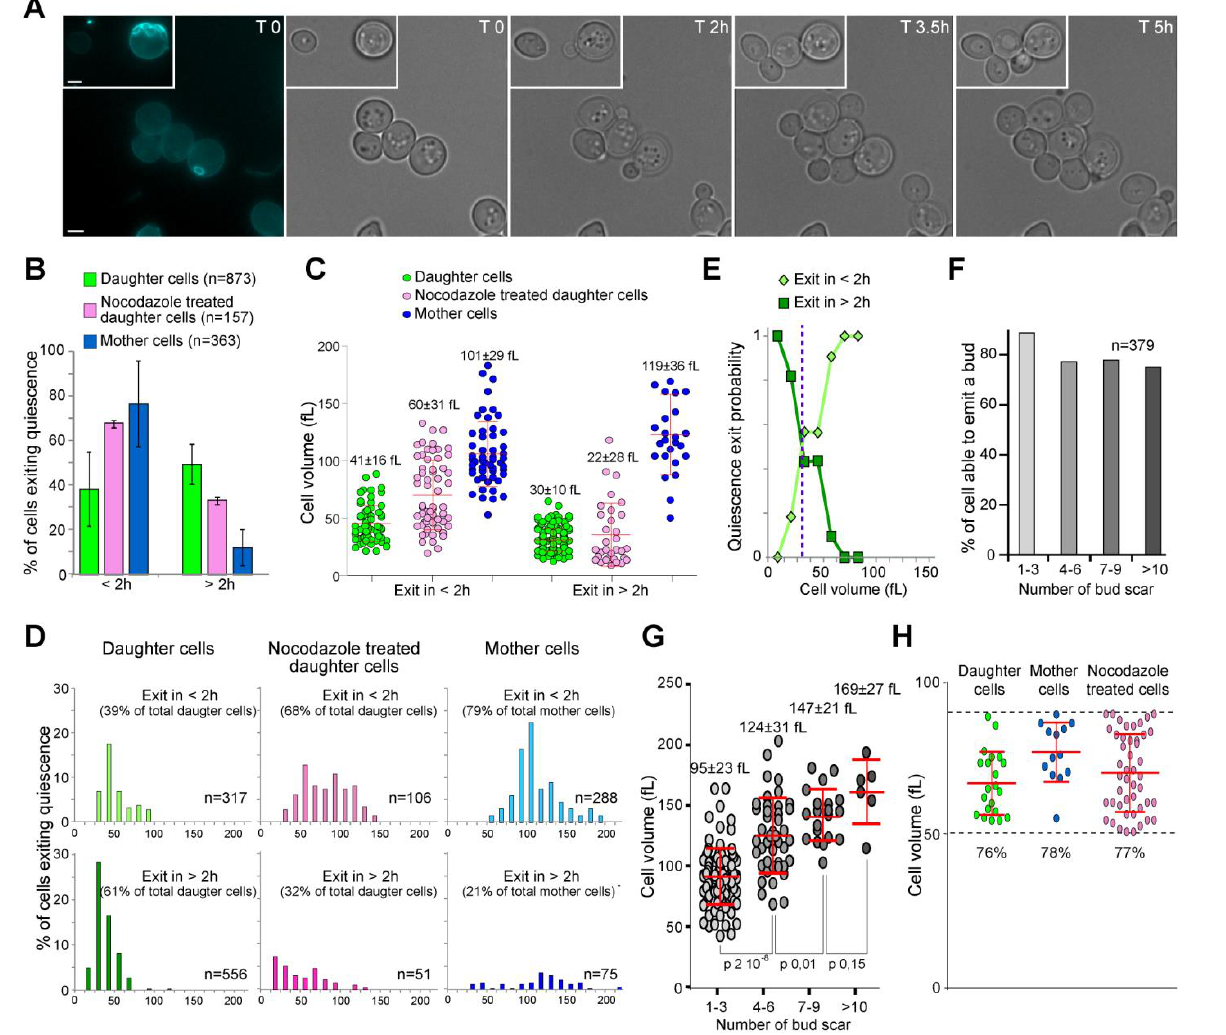
FIGURE 1: Daughter and mother cell quiescence exit efficiency. (A) Image series of 7-day-old wild type mother and daughter cells exiting quiescence on a YPD-containing microscope agarose pad. The first image shows a calcofluor white staining revealing bud scars (blue). Bar is 2 µm. (B) Percentage of 7-day-old wild type mother and daughter cells able to exit quiescence in less than 2 h (< 2 h) or between 2 and 6 h (> 2 h) on a YPD-containing microscope agarose pad at room temperature (N=3, the number of cell scored is indicated). Histograms are means and bars are SD. (C) Initial volume in function of the time needed for bud emergence. Cells are the same as in (B). Median cell volume and SD are indicated. (D) Volume distribution according to quiescence exit swiftness. Cells are the same as in (B), top graphs: emit a bud in less than 2 h; lower graphs: emit a bud within 2 to 6 h. The percentage of each sub-populations and the number of analyzed cells are indicated. (E) Probability of a daughter cell to exit quiescence in less or more than 2 h, according to its volume in quiescence. (F) Percentage and (G) vol- ume of mother cells able to exit quiescence in less than 2 h, accordingly to their replicative age. Median cell volume and SD are indicated. (H) Cell ability to exit quiescence in less than 2 h within an identical cell volume range (50 to 90 fL). In all panels, mother cells are in blue, daugh- ter cells in green, and nocodazole treated cells in